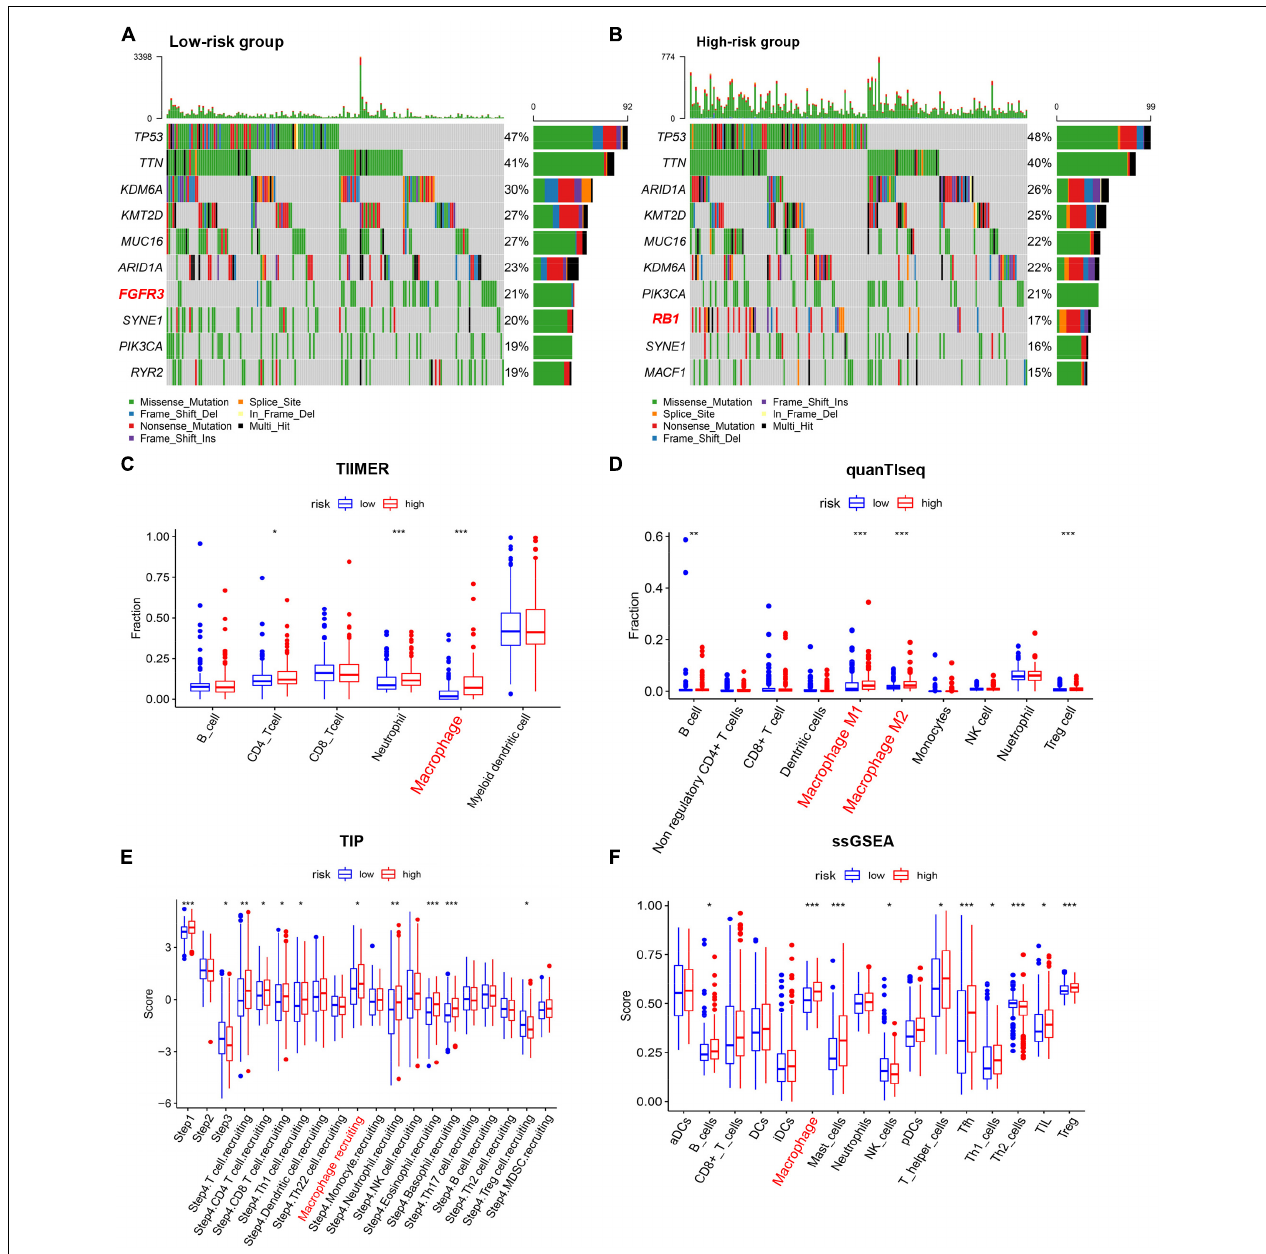
FIGURE 6 | Characterization of immune cell infiltration and mutation landscape in BC tissues among different risk groups. (A,B) Somatic mutation profiles of BC tissues among different risk groups. (C–F) Boxplots of Immune cell infiltration with high and low risk scores estimated using TIMER, quanTIseq, TIP, and ssGSEA. * p < 0.05, ** p < 0.01, *** p <